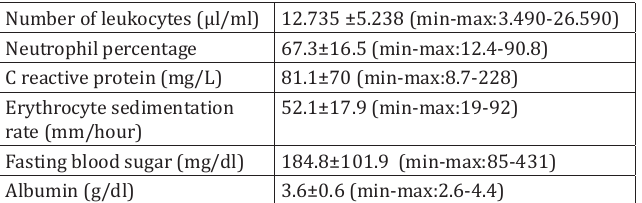
Laboratory features of patients with cellulitis